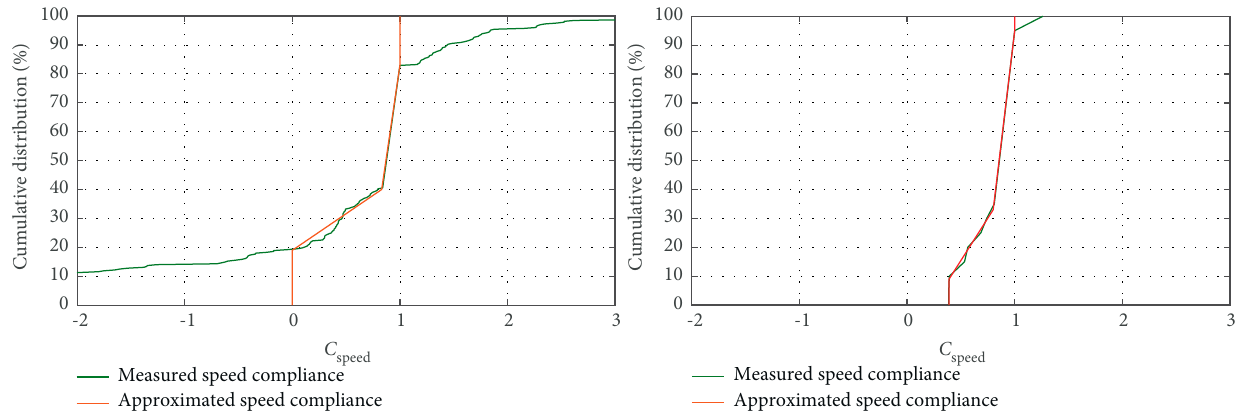
Figure 6: Estimated and approximated speed compliance distributions based on field trial